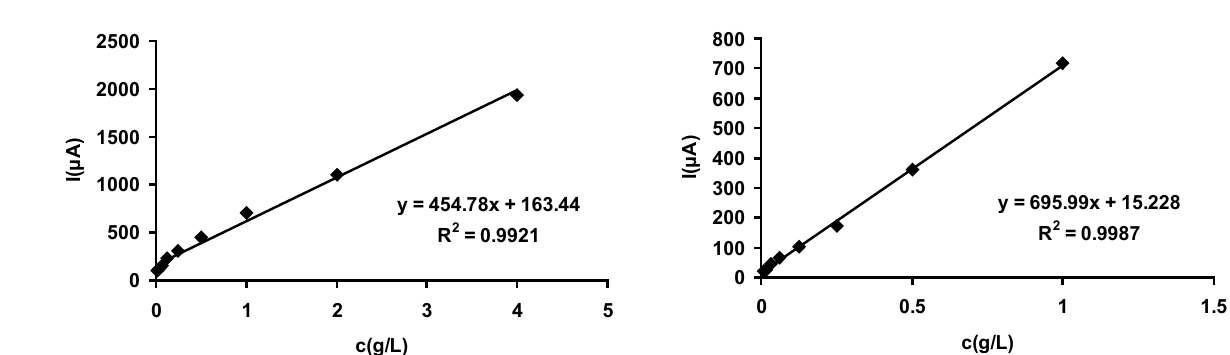
y = 695.99x + 15.228